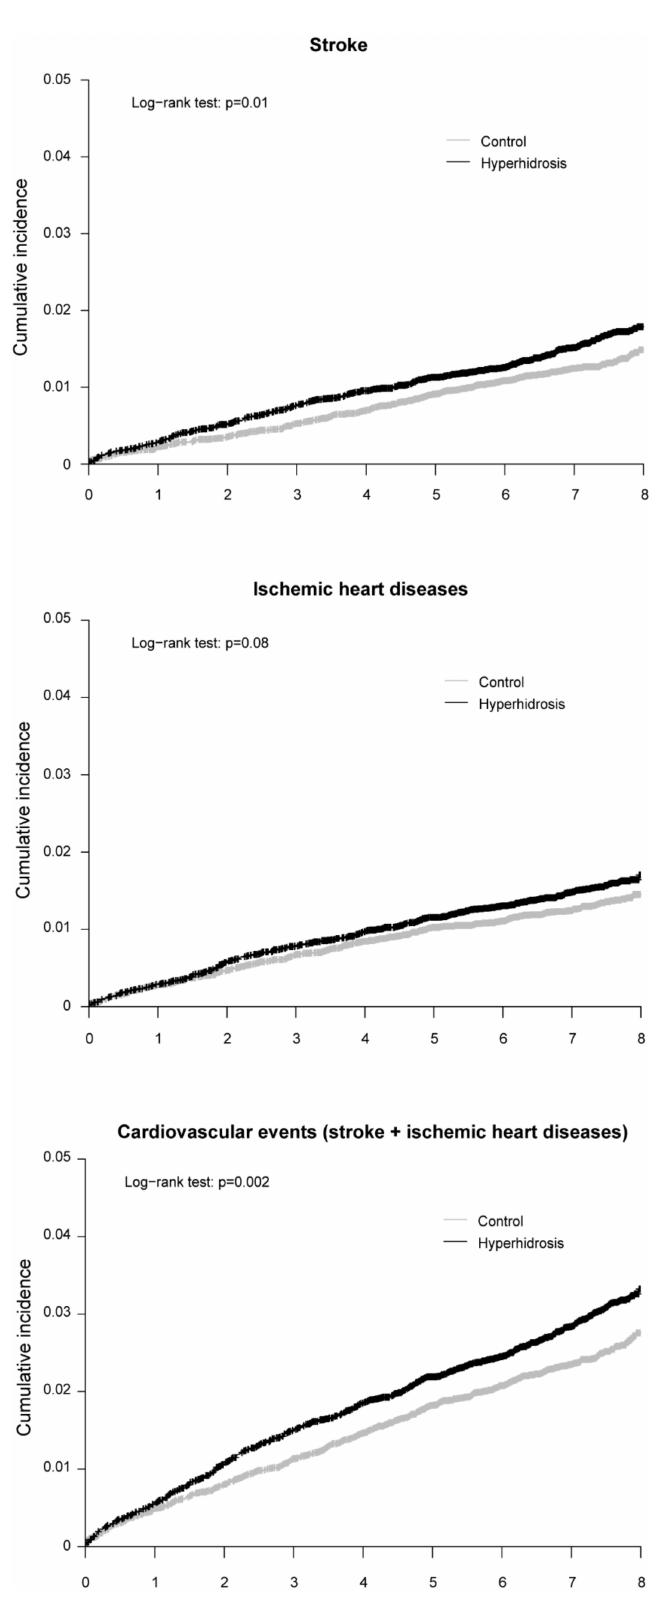
Figure 2. Kaplan–Meier curves with cumulative incidence of cardiovascular events stratified by the presence or absence of hyperhidrosis using log-rank